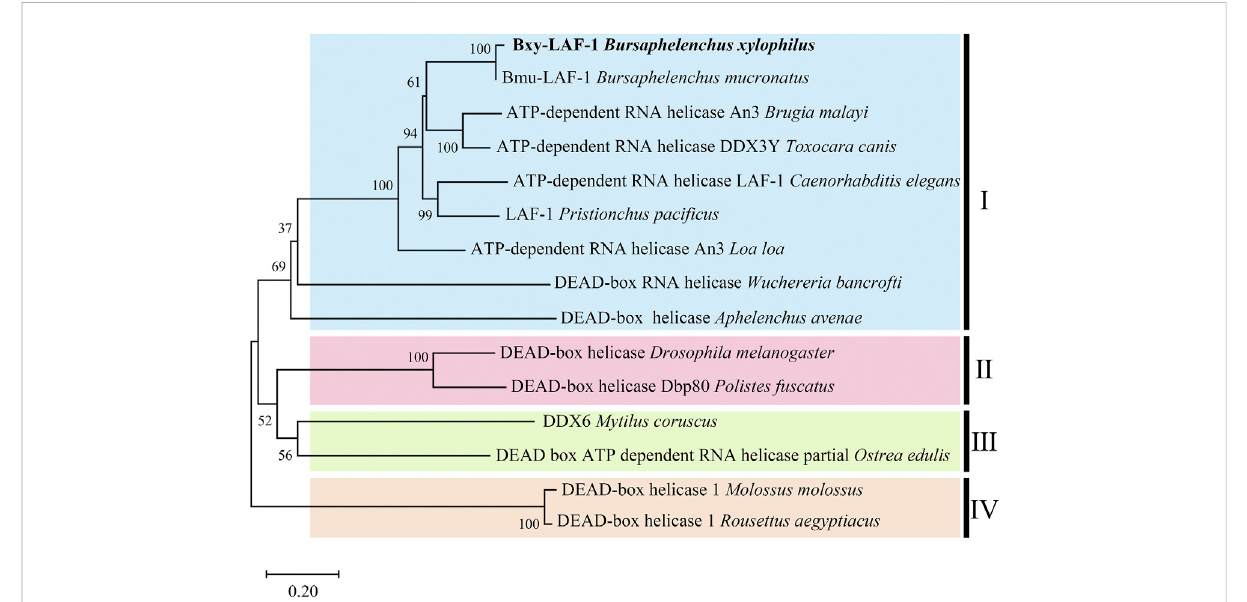
FIGURE 2 PhylogeneticanalysisofLAF-1sfromdifferentspecies.Thescalebarindicatesevolutionarydistance(0.20substitutionsperposition). Ⅰ (LAF-1sin Nematoda): Bursaphelenchus xylophilus (CAD5234552.1), Bursaphelenchus mucronatus (OM210018), Brugia malayi (XP 042930654.1), Toxocara canis (KHN84719.1), Caenorhabditis elegans (NP 001254859.1), Pristionchus paci fi cus (KAF8381410.1), Loa loa (XP 003140162.1), Wuchereria bancrofti (EJW85565.1), Aphelenchus avenae (KAH7731651.1); Ⅱ (LAF-1s in Arthropoda): Drosophila melanogaster (AAC23709.1), Polistes fuscatus (XP 043504272.1); Ⅲ (LAF-1s in Molluscs): Mytilus coruscus (CAC5359041.1), Ostrea edulis (AFJ91775.1); Ⅳ (LAF-1s in Chordata): Molossus (KAF6429176.1), Rousettus aegyptiacus